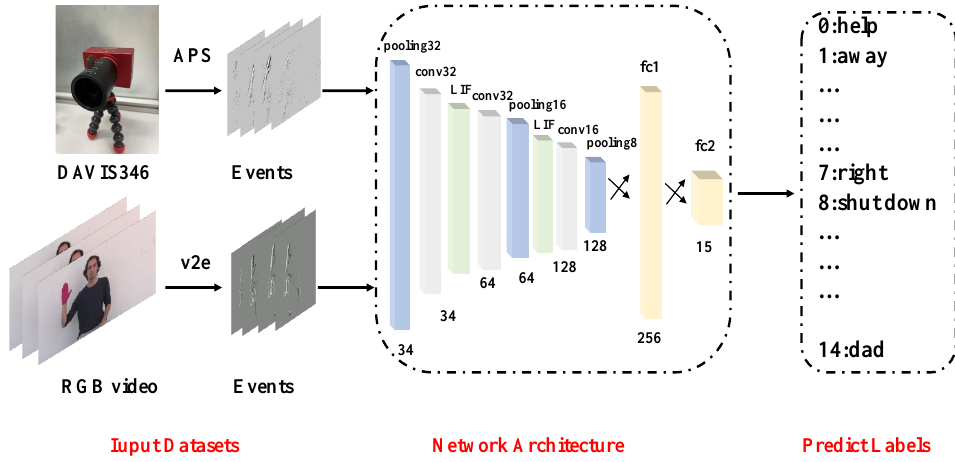
Figure 3. The process of sign language gesture recognition and classification. The two datasets in the figure do not enter the network at the same time, so the drawing is for a more intuitive display.